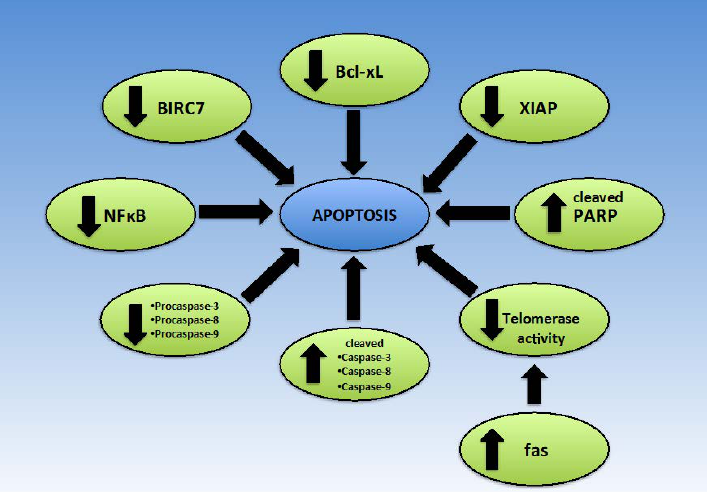
Figure 4. Effect of Mangiferin on proteins implicated in apoptosis.